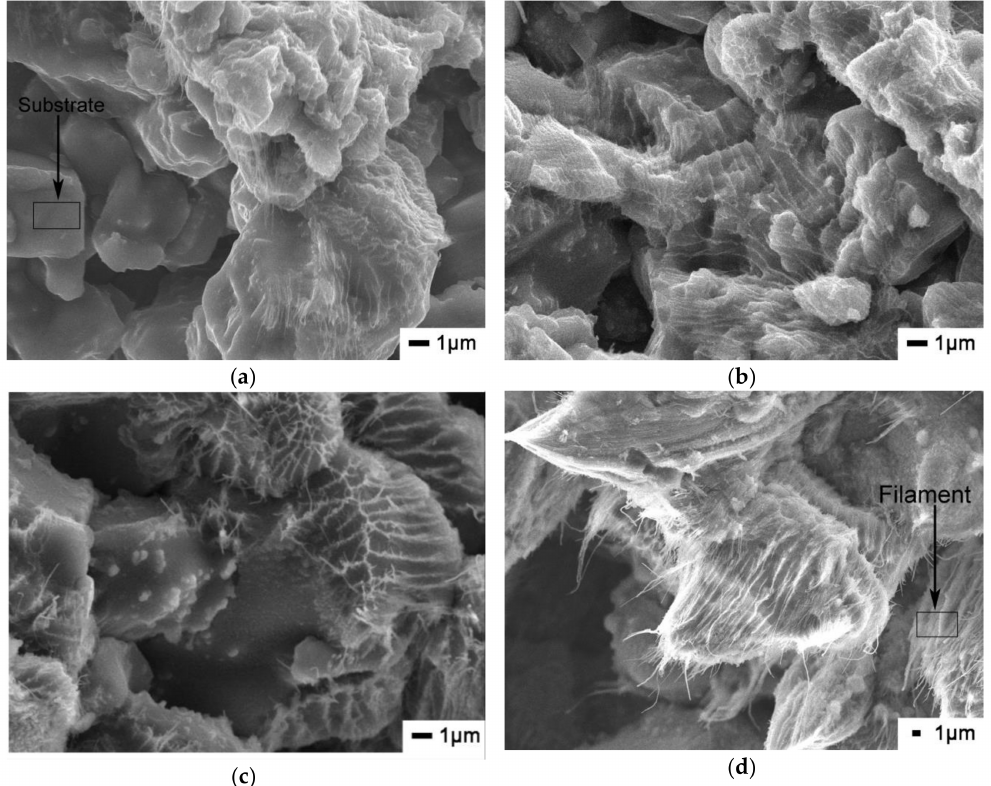
Figure 7. SEM micrograph of the superplastic fracture surface morphologies at T = 400 ◦ C, . ε = 1 × 10 − 3 s − 1 ( a ), T = 450 ◦ C, . ε = 5 × 10 − 4 s − 1 ( d